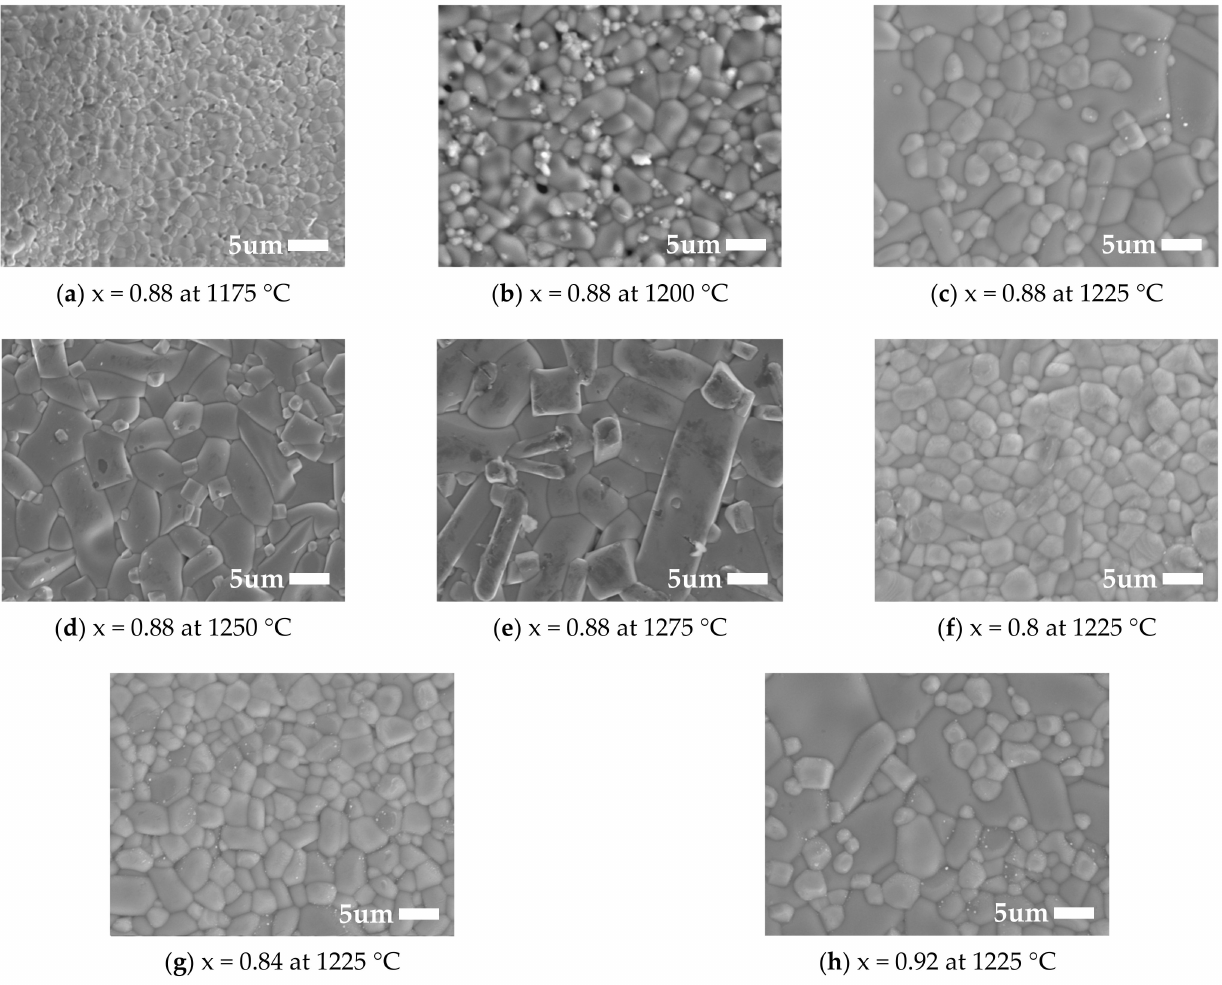
Figure 3. ( a – h ) Scanning electron microscopy photographs of Ca 0.6 La 0.8/3 TiO 3 -modified (Mg 0.6 Zn 0.4 ) 0.95 Ni 0.05 TiO 3 with x = 0.88 sintered from 1175 ◦ C to 1275 ◦ C for 4 h and with various x values sintered at 1225 ◦ C for 4